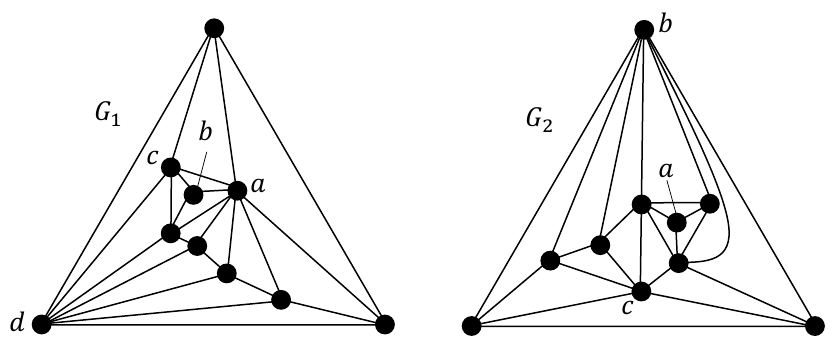
and G on the sphere with guarding number 3 which have no 1 2